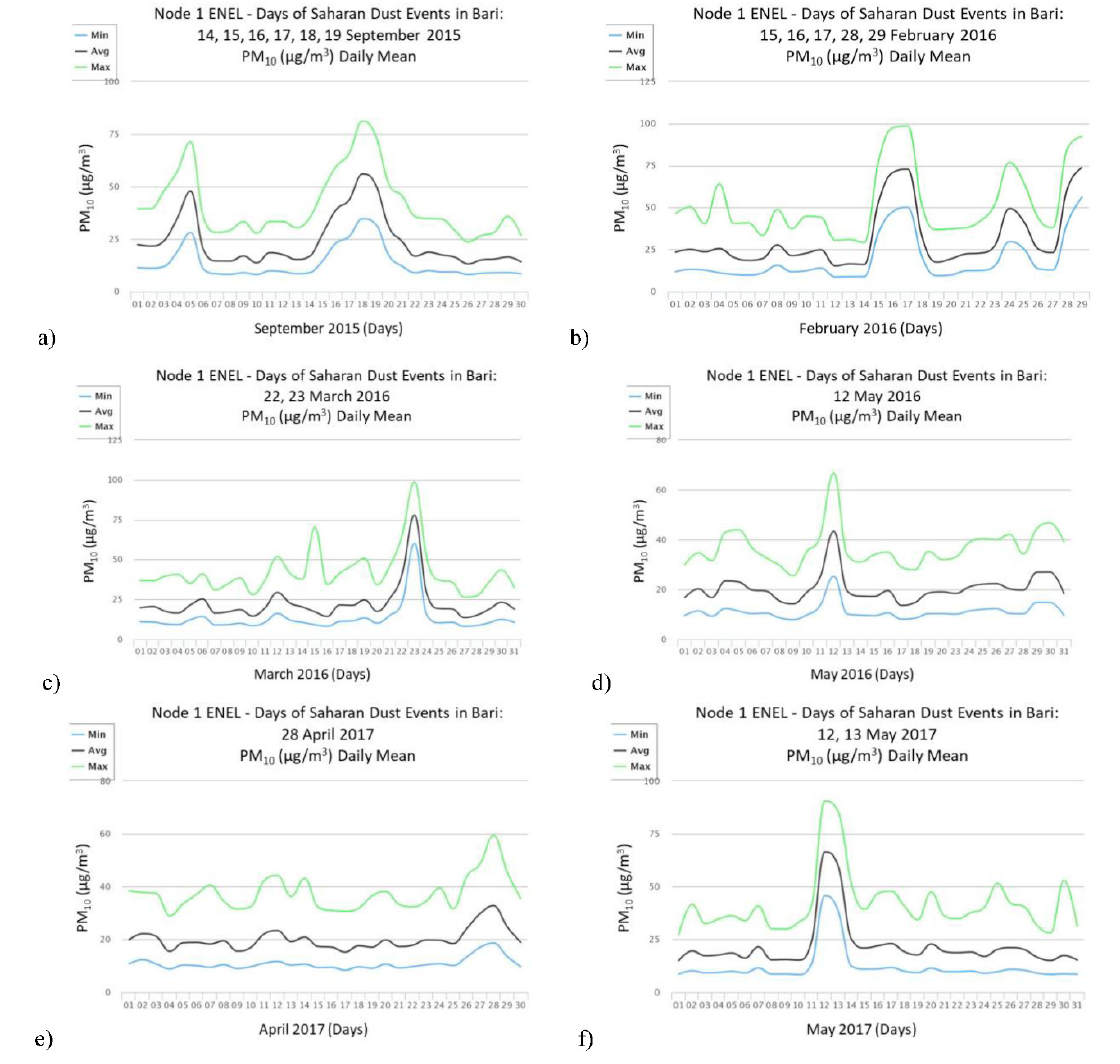
Figure 1. PM 10 daily mean ( μ g/m 3 ) time-series of the sensor node (Node 1), installed on the roof of the ENEL building (Longitude East: 16.87370 and Latitude Nord: 41.11720), close to a street with daily busy traffic: ( a ) September 2015; ( b ) February 2016; ( c ) March 2016; ( d ) May 2016; ( e ) April 2017; ( f ) May